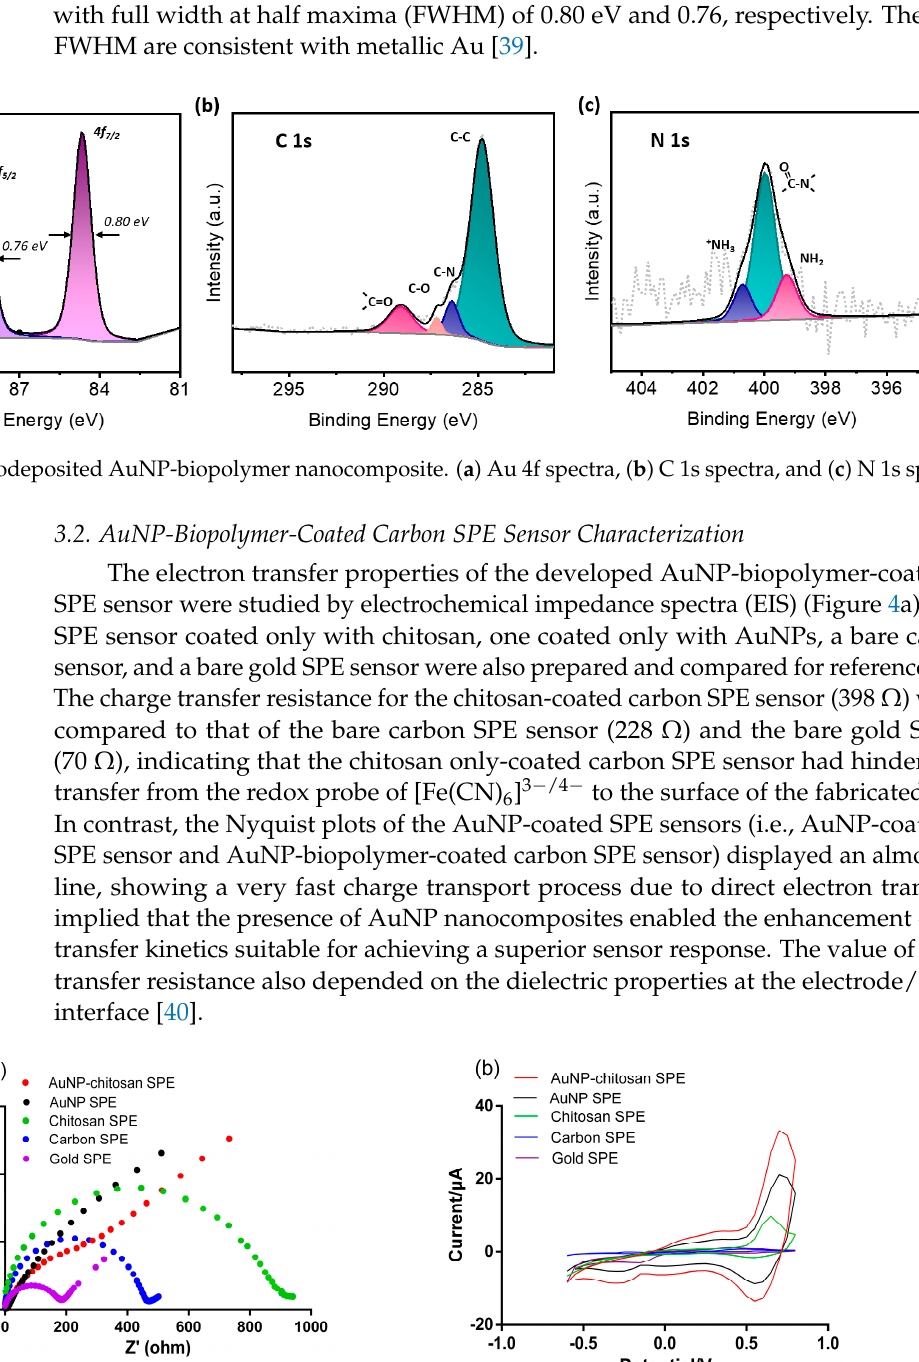
Figure 2. SEM and EDS mapping of AuNP-biopolymer composite film electrodeposited on a carbon electrode. The electron map obtained with the secondary detector is shown ( a ), with the corresponding carbon intensity map ( b ), and gold intensity map ( c ). All scale bars are 1 μ m.